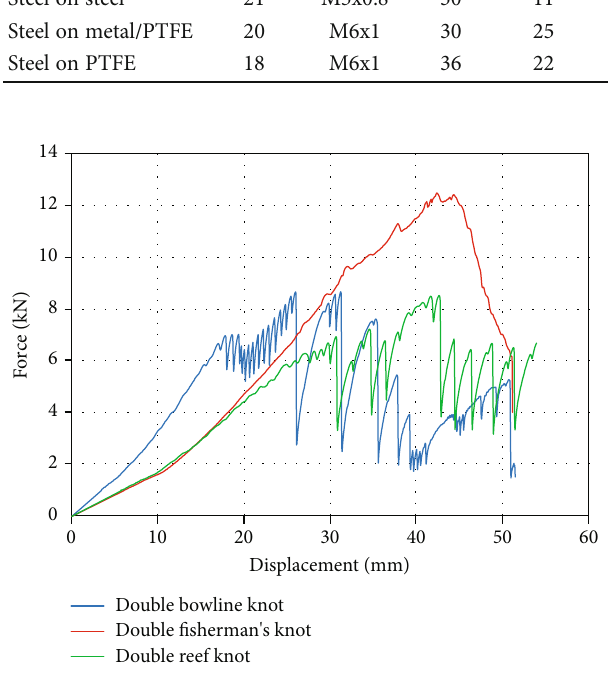
Figure 6: Mechanical behavior of a Kevlar rope with di ff erent types of knots.